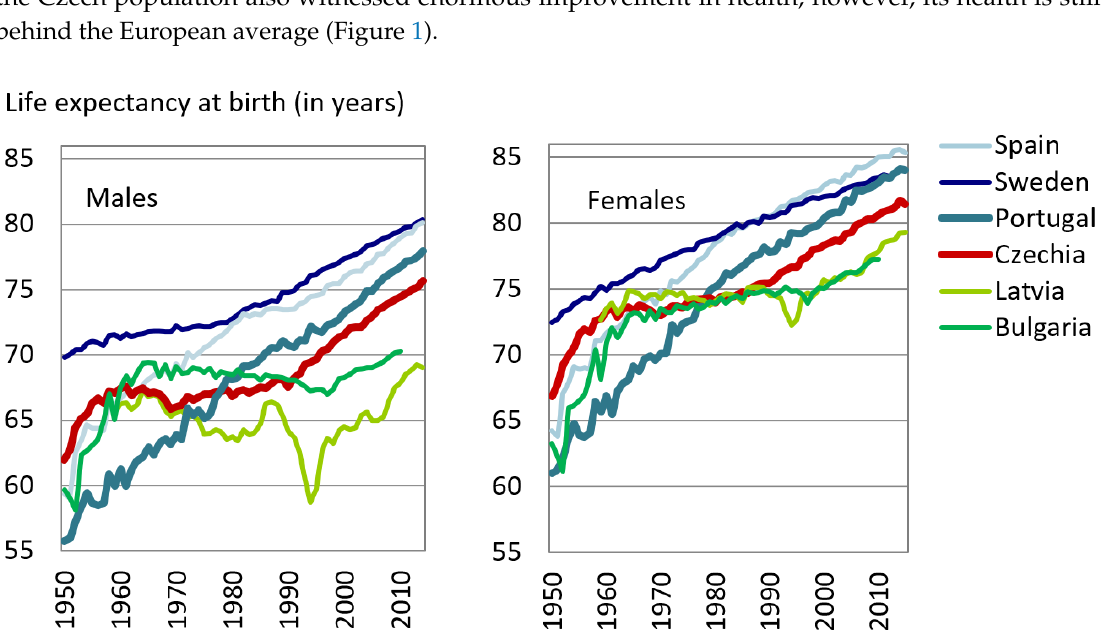
Figure 1. Trends in life expectancy in selected European countries, 1950 – 2015. Note: Sweden and Spain show the maximum male and female life expectancy, respectively, at birth within EU countries. On the other hand, Latvia and Bulgaria show the minimum male and female life expectancy, respectively, at birth within the EU countries. Data source: Human Mortality Database. University of California, Berkeley (USA), and Max Planck Institute for Demographic Research (Germany). Available at www.mortality.org or www.humanmortality.de (data downloaded on March 10, 2019).